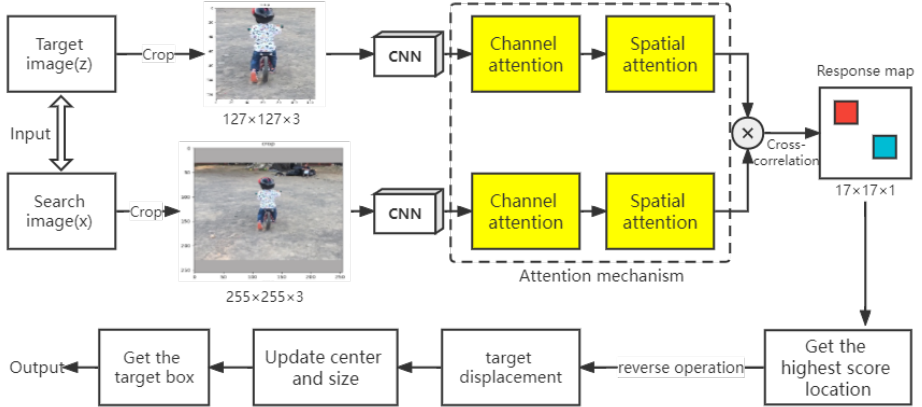
Figure 1. The overall architecture of the proposed tracker. We have highlighted the added attention mechanism module in